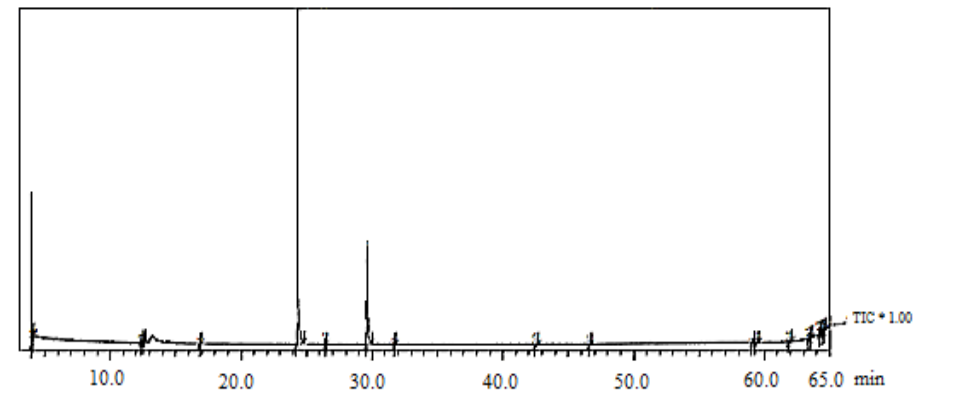
Figure 3. GC–MS chromatogram of M. longifolia EO. Where (*) is the Total Ion Current. Figure 3. GC – MS chromatogram of M. longifolia EO. Where (*) is the Total Ion Current. Table 1. The relative percentage of the area of peak of M. spicata EO constituents.